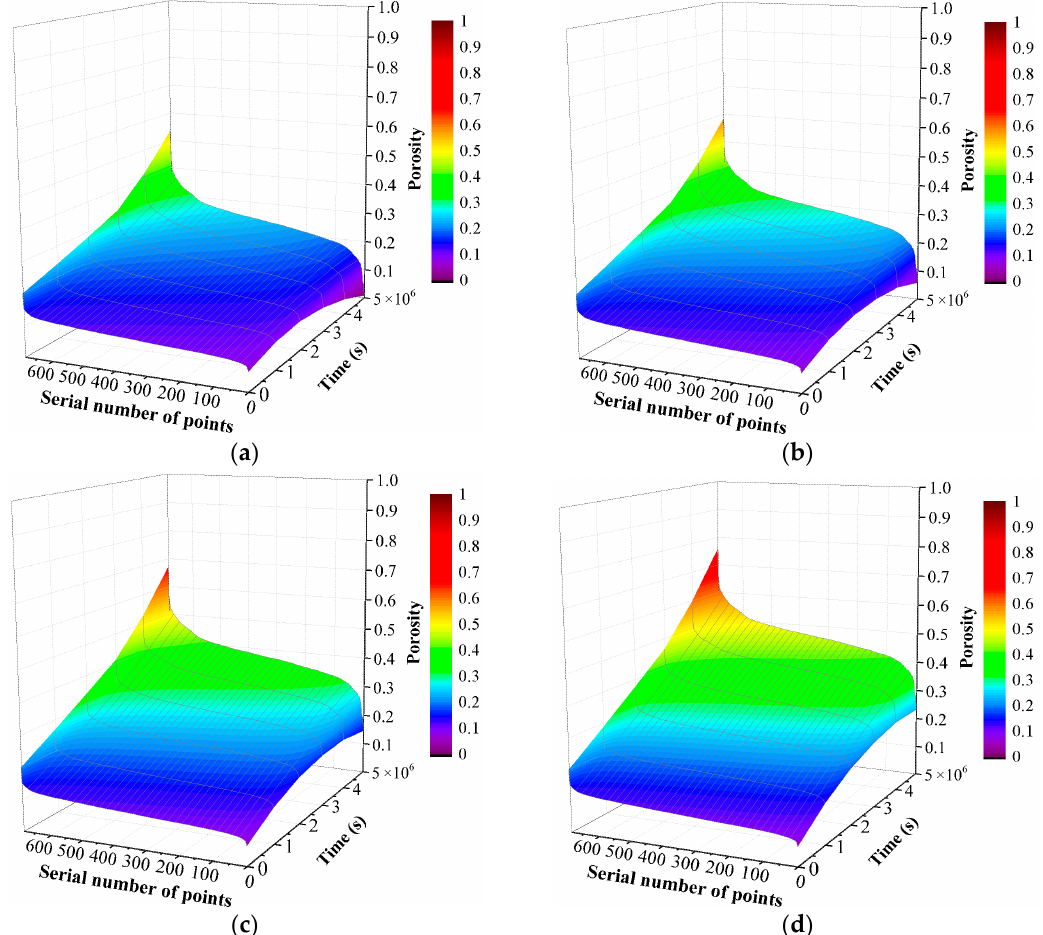
k = 2): ( a ) pH = 6.6; ( b ) w